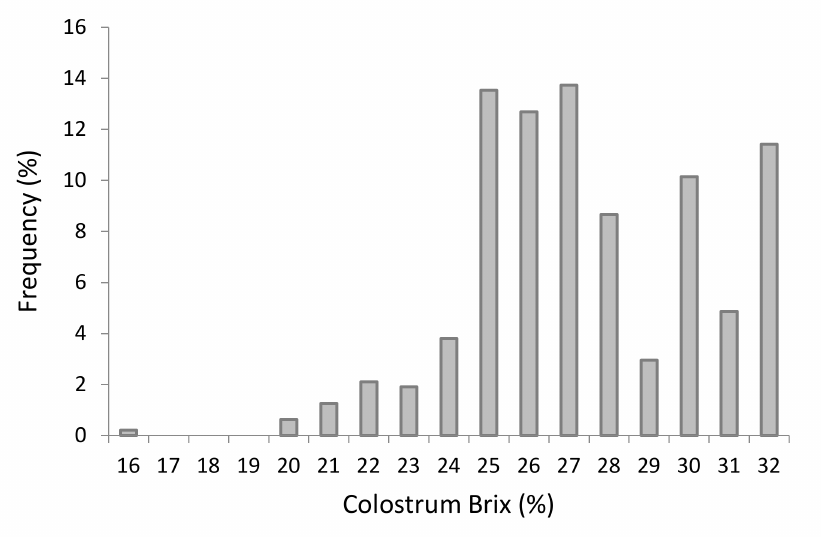
Figure 4. Distribution of Brix% of colostrum collected from dams. The distribution of serum Brix refractometry of female Holsteins at two days of life is shown in Figure